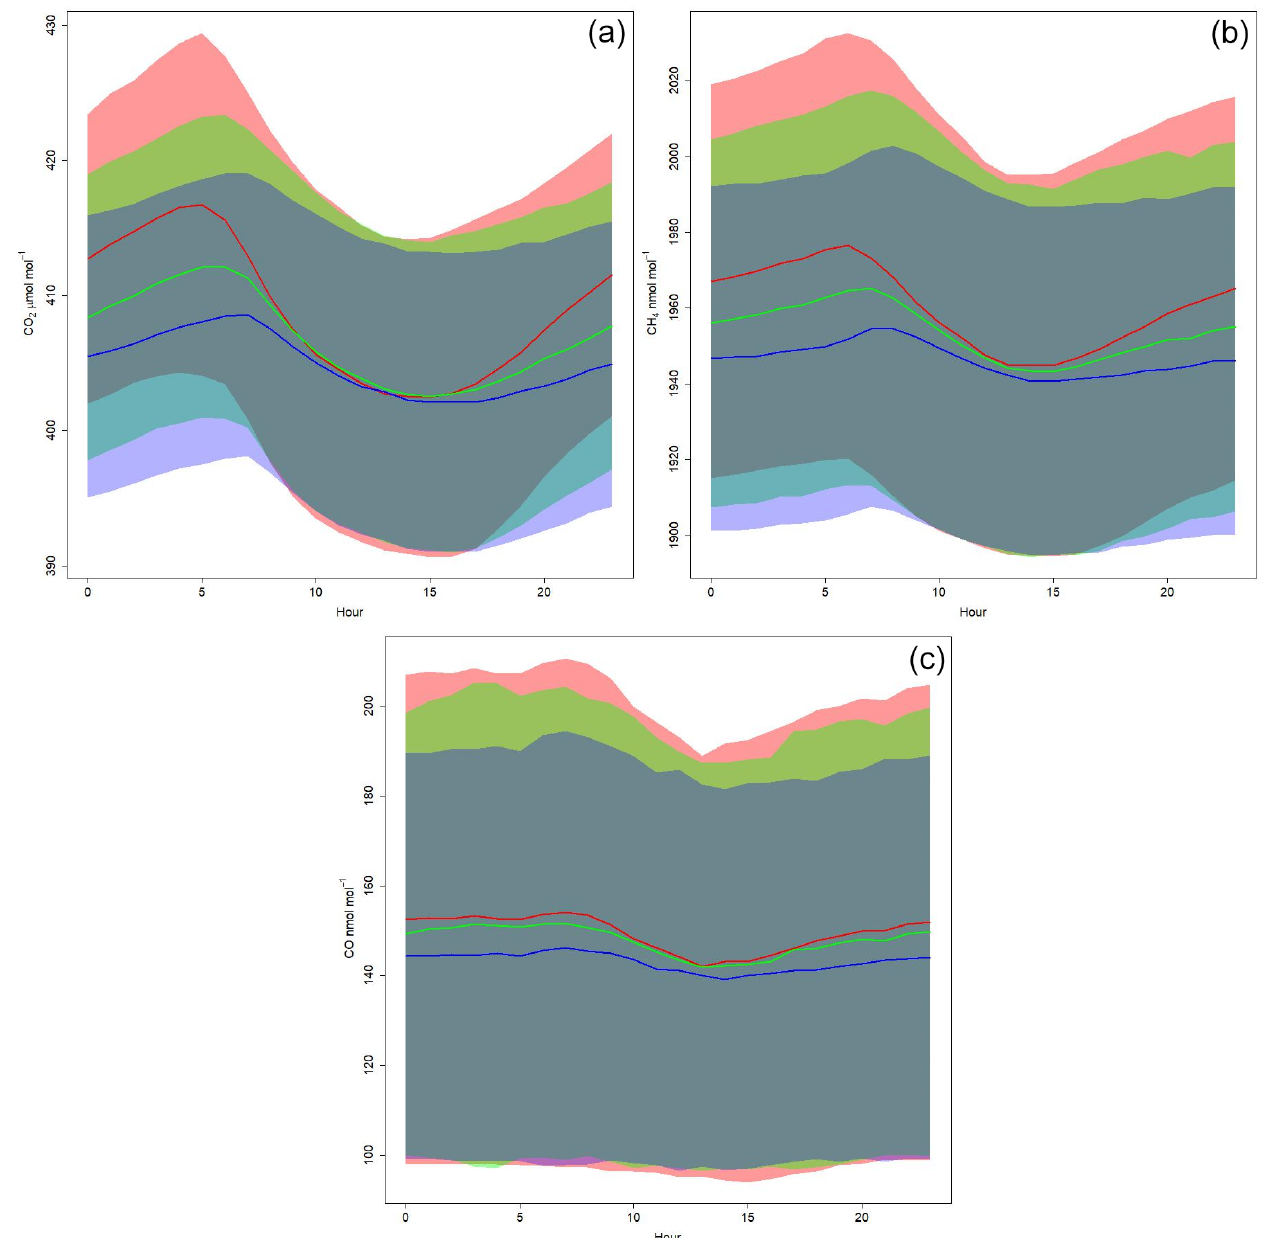
Figure 10. Mean diurnal cycles of CO 2 (a) , CH 4 (b) and CO (c) for the three sampling levels 10m (red), 50m (green) and 120m (blue), computed over the period 2011–2018. The shaded areas correspond to the + and − 1 standard deviations around the mean diurnal